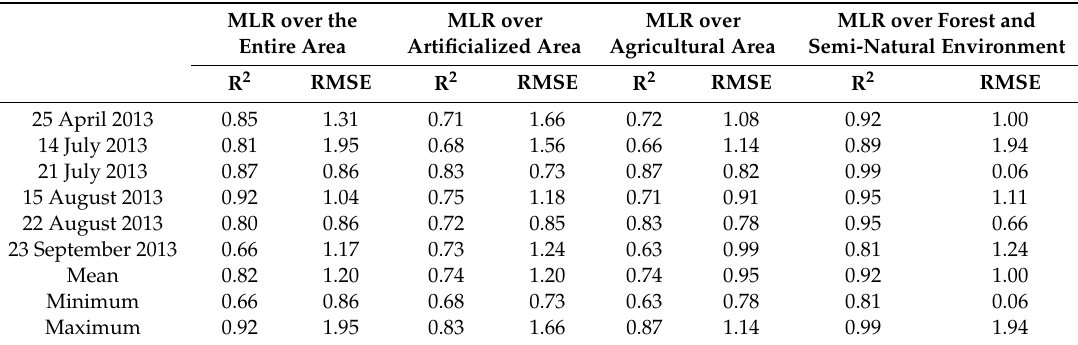
Table 6. Part of the variance explained in the modeling of air temperature over the entire study area and by land cover. MLR over